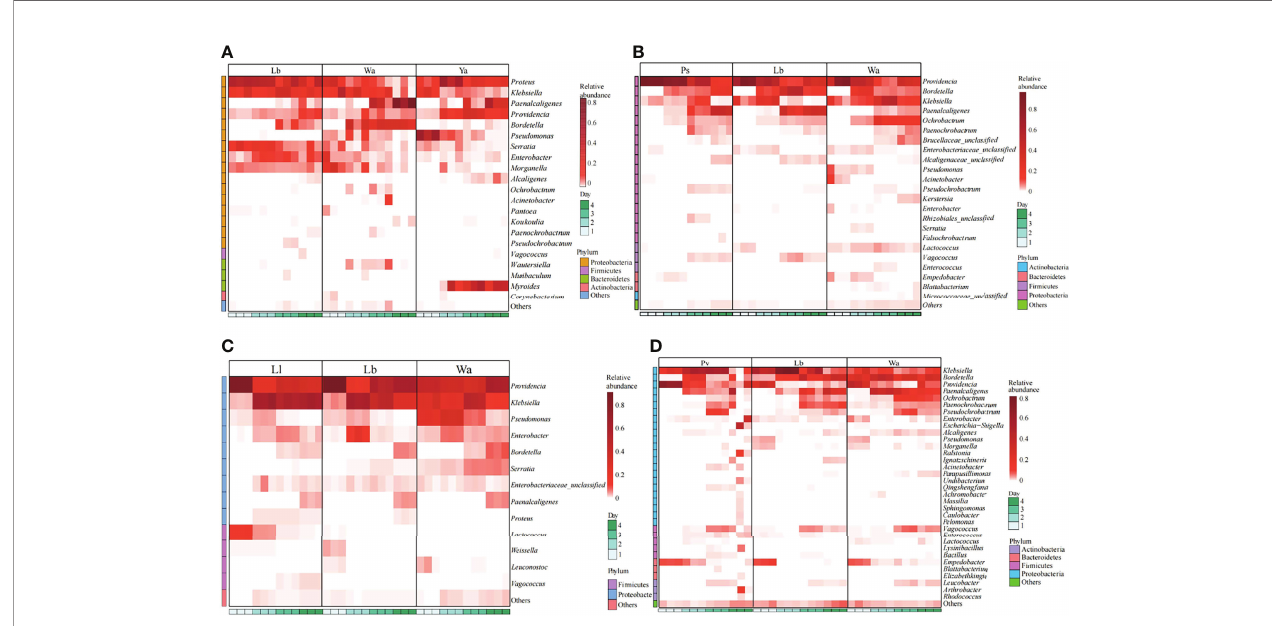
FIGURE 5 | Effects of “ harmful bacteria ” (A – C) and “ neutral bacteria ” (D) in the guts of house fl y larvae on the composition of gut fl ora of larvae. Ya, Pseudomonas aeruginosa ; Ps, Providencia stuartii ; Pv, Providencia vermicola ; Ll, Lactococcus lactis . Wa, sterile water, blank control group; Lb: Luria-Bertani liquid medium, negative control group; Day 1, Day 2, Day 3, Day 4: the developmental period of house fl y larvae.